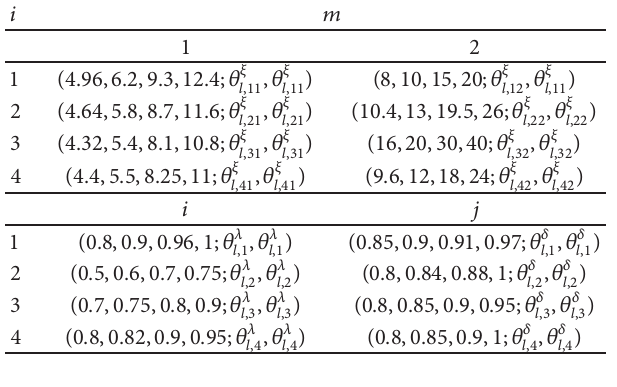
Table 5: Parameters related to acquisition costs and proportions of different emergency supplies.